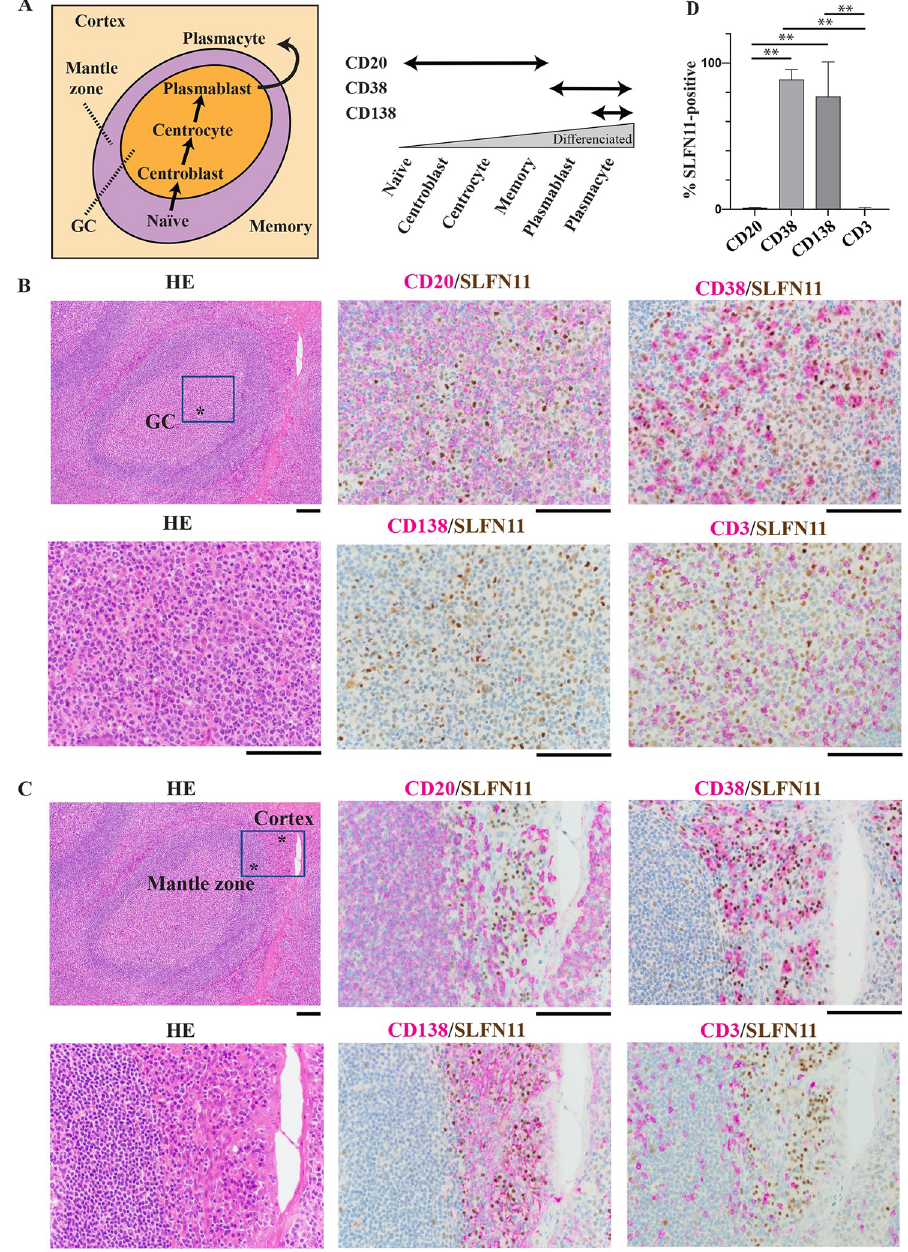
Fig 2. SLFN11 expression is suppressed in germinal center B-cells. Immunohistochemical staining of human tonsil tissue. The samples were stained with hematoxylin eosin (HE). For dual staining, SLFN11 was stained with DAB (brown) and CD markers (CD3, CD20, CD38 and CD138) were with HRP (purple). Original magnification: x10 and x40. Scale bars are 100 μ m. GC: germinal center. (A) Left: schematic illustration of B-cell localization in lymphatic tissues. Right: CD markers expression during B-cell development. (B) Germinal center in tonsil tissue. (C) Mantle zone and cortex in tonsil tissue. (D) Proportion of SLFN11 positive cells in CD marker positive cells. �� p < 0.0001. conditions, SLFN11 gene expression was upregulated by both of the epigenetic modifiers across all the cell lines examined (Fig 4B). The activation of SLFN11 expression was validated at the protein level in FL18 and FL318 cells after the treatment with either epigenetic modifier